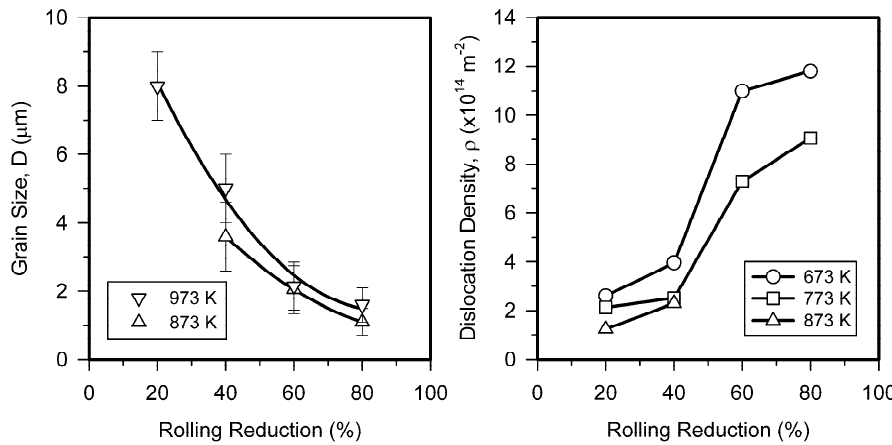
Figure 6. Effect of cold rolling reduction and annealing temperature on the grain size and dislocation density after recrystallization and recovery annealing of a high-Mn steel.